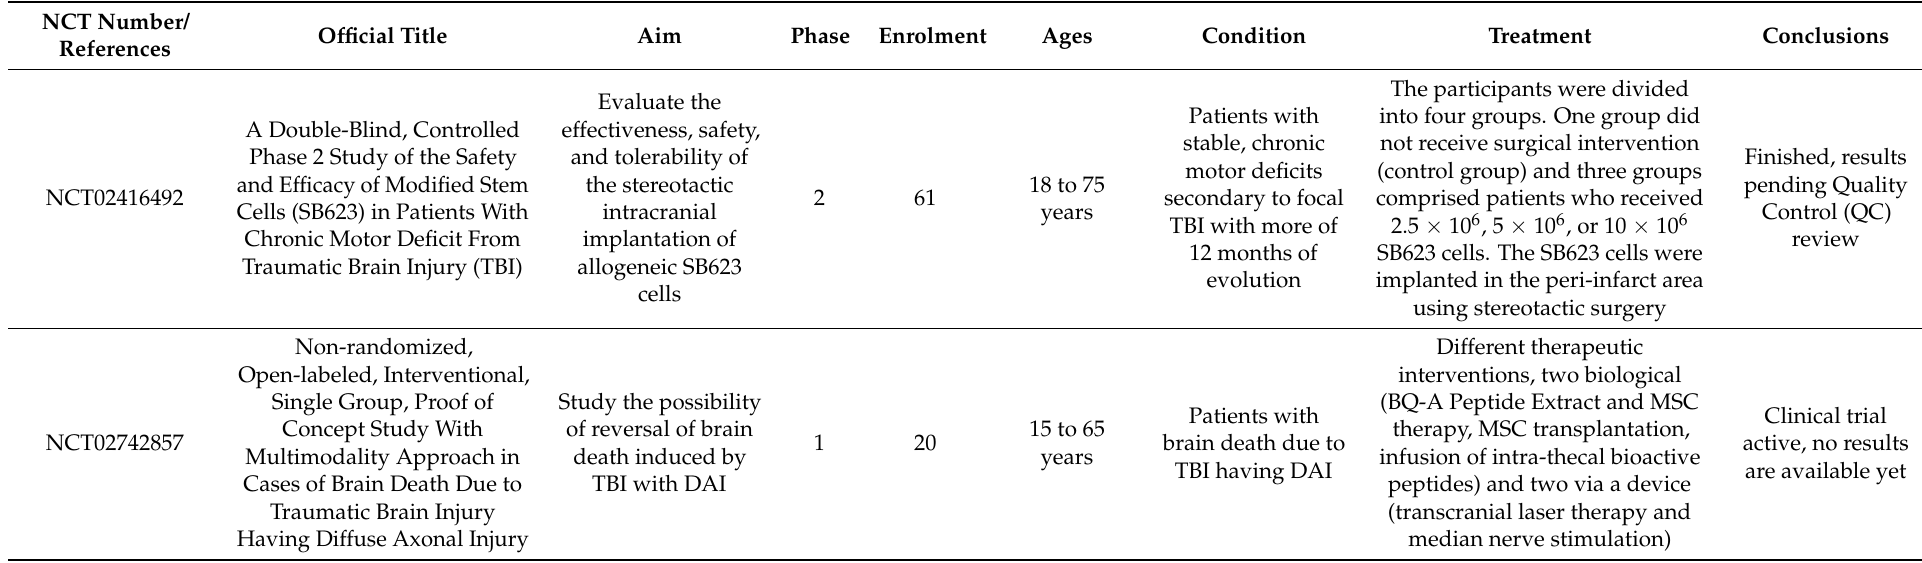
Table 2. Clinical trials of non-autologous SC therapies recorded on